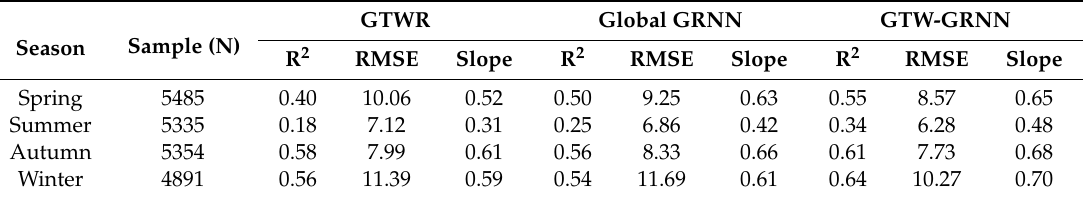
Table 1. Site-based cross-validation (CV) performance of the models for each